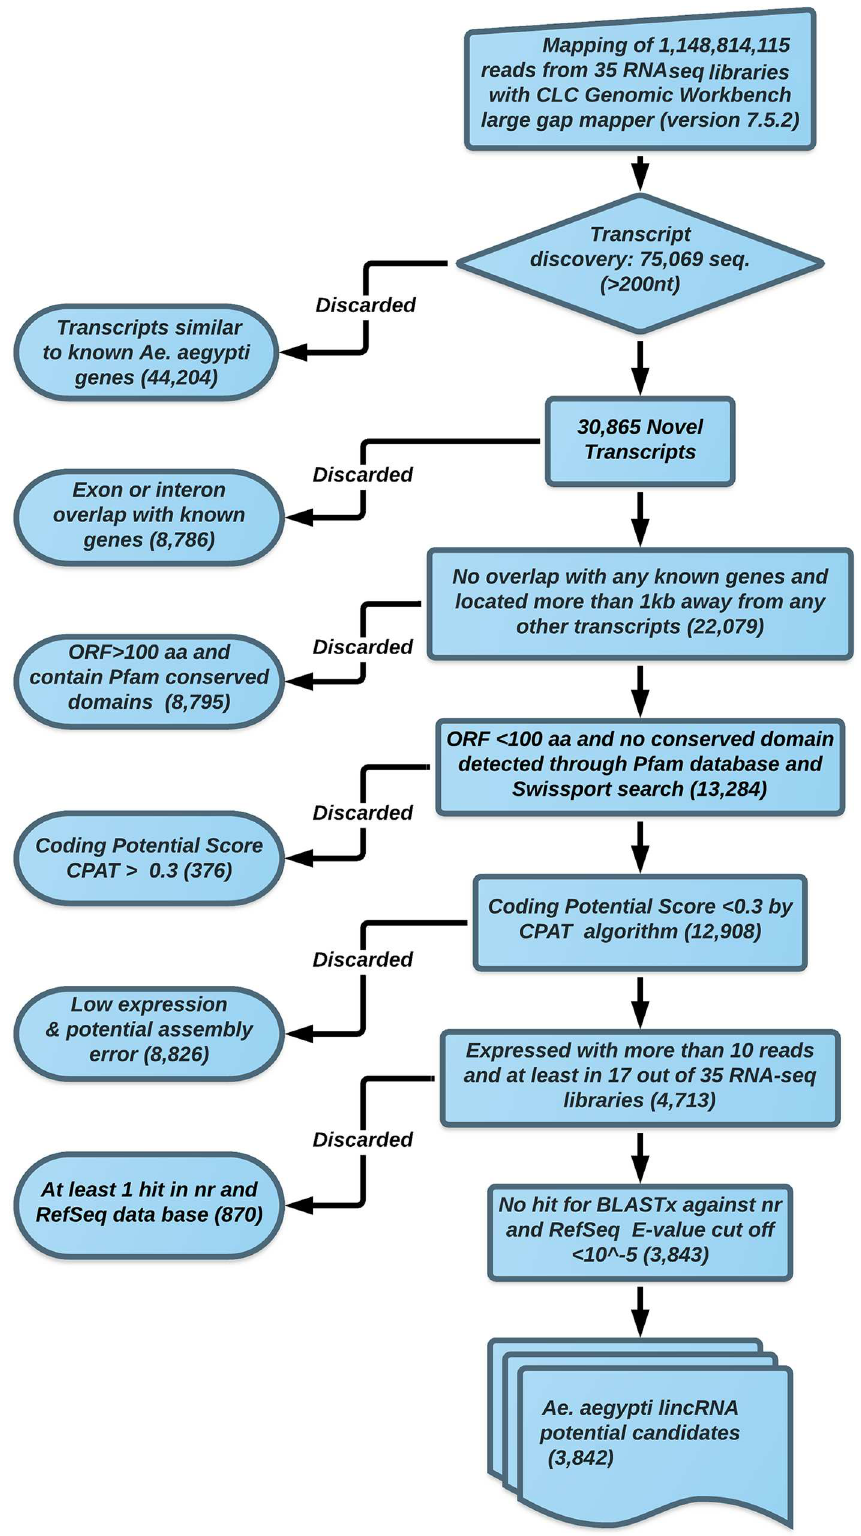
Fig 1. The lincRNA identification pipeline flowchart.